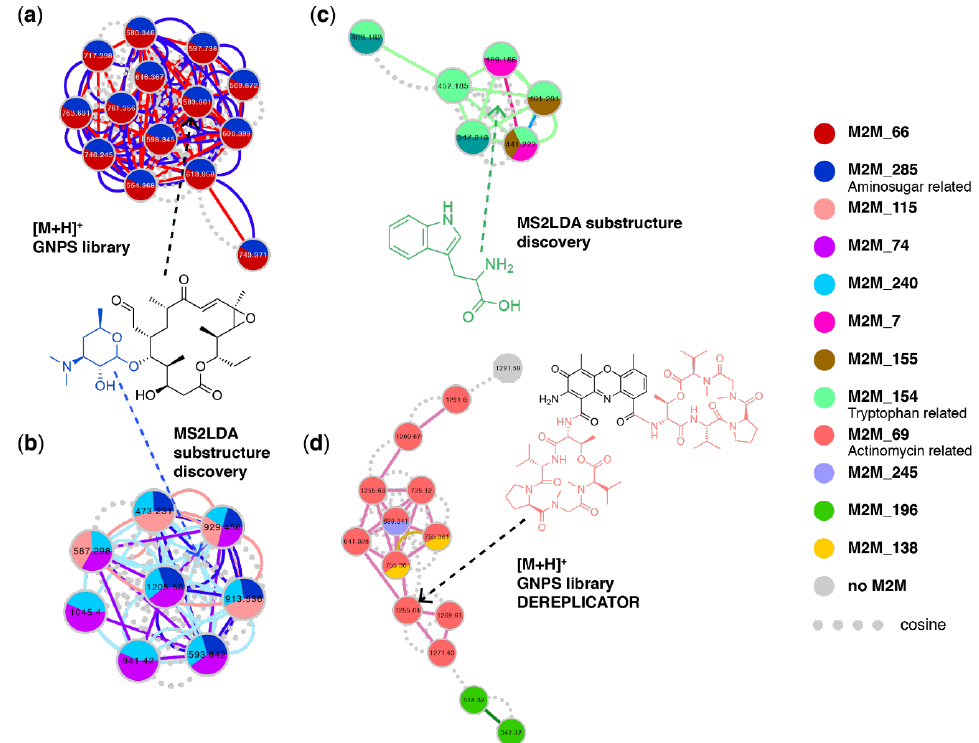
Figure 6. Molecular families from marine sediment bacteria with color coded Mass2Motif substructure information mapped on them, with ( a ) rosamicin-related molecular family found through GNPS library hits where all members contain an amino sugar-related motif as colored in blue in its depicted structure—substructures or motifs found within each molecular feature are mapped on the nodes as pie charts, where the relative abundance of each motif represents the overlap score, a score measuring how much of the motif is present in the spectrum. Furthermore, motifs shared between two nodes are visualized as colored continuous lines (edges) connecting the nodes whereas dashed lines (edges) represent a cosine score of over 0.6, ( b ) Yet unknown molecular family that shares an amino sugar-related motif connecting this MF to ( a ) by sharing a substructure, ( c ) tryptophan-related molecular family sharing the Tryptophan Mass2Motif, and ( d ) actinomycin-related molecular family—found through GNPS library hits and further validated with help of DEREPLICATOR results—sharing an Actinomycin related motif across most of its members. The actinomycin D (Daptomycin) structure is depicted with the Mass2Motif substructure highlighted in color: the peptide lactone ring present twice in the molecule. In all MFs, nodes are colored based on Mass2Motif overlap scores and the edges show if cosine score-connected nodes share similar Mass2Motifs. It can be seen that in all families multiple motifs are shared across some of its